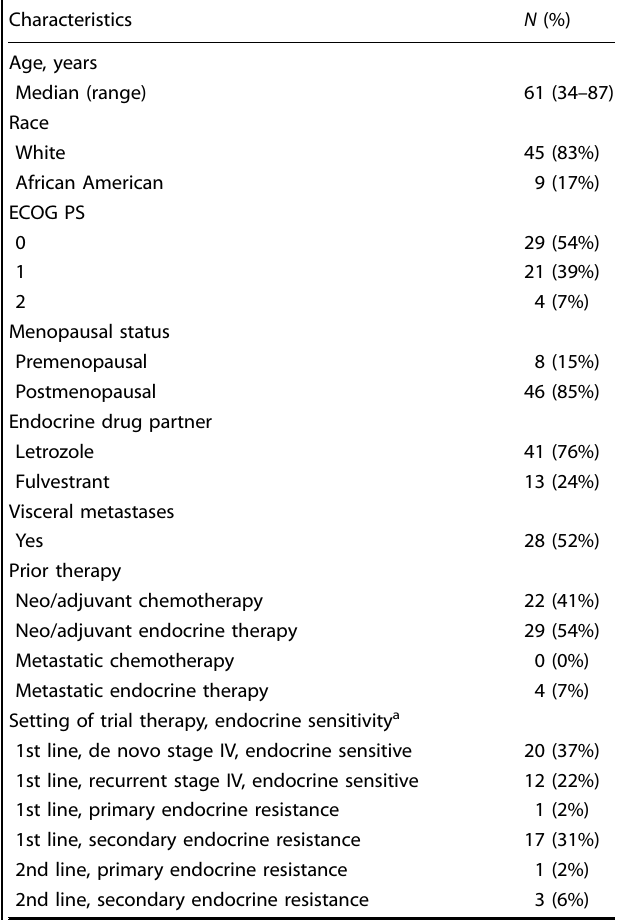
Table 1. Clinical Characteristics ( n = 54).